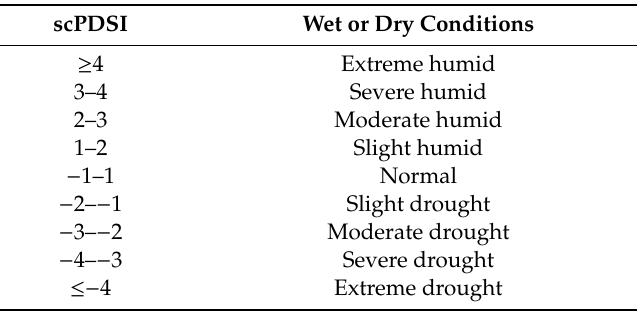
Table 2. The wet or dry conditions based on